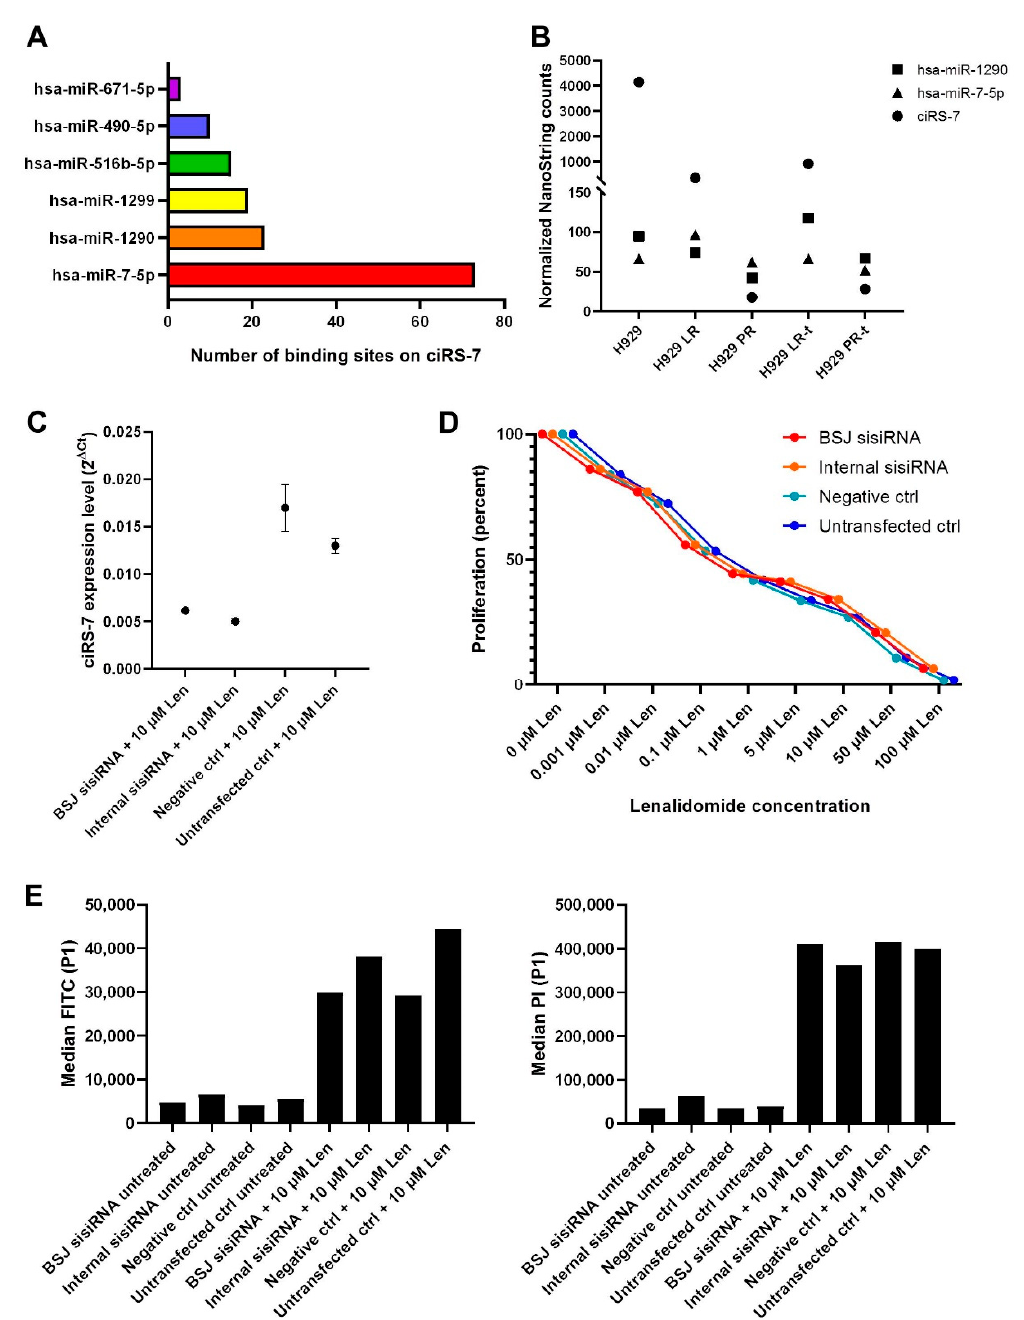
Figure 7. Knockdown of ciRS-7 does not induce IMiD resistance in sensitive cells. ( A ) The top five miRNAs with binding sites on ciRS-7, according to CircInteractome [48], and miR-671. ( B ) miR-7, miR-1290 and ciRS-7 expression in IMiD-sensitive (H929), LR cells, PR cells, LR cells treated with EZH2i and DNMTi (LR-t), and PR cells treated with EZH2i and DNMTi (PR-t). ( C ) Expression of ciRS-7 five days post sisiRNA transfection. Relative expression of ciRS-7 (analyzed by RT-qPCR) in cells transfected with two different sisiRNA targeting ciRS-7 (denoted as BSJ and Internal) treated with 10 µ M lenalidomide. For ciRS-7 expression after knockdown in untreated cells, see Figure 4C. Error bars reflect technical triplicates. ( D ) Dose- response curves for lenalidomide in sisiRNA-transfected IMiD-sensitive cells. ( E ) Measurement of early apoptotic cells using fluorescein isothiocyanate (FITC) signal, and necrotic cells using propidium iodide (PI) signal, from sisiRNA-transfected parental cells treated with 10 µ M lenalidomide. LR: lenalidomide-resistant, PR: pomalidomide-resistant, BSJ: back-splicing junction, ctrl: control, Len: lenalidomide.